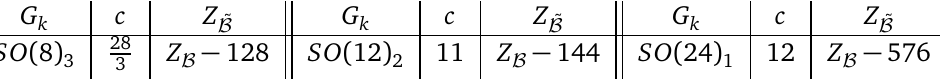
: primaries labeled by i are characterized by weights h and SO ( 12 ) Dynkin la- 2